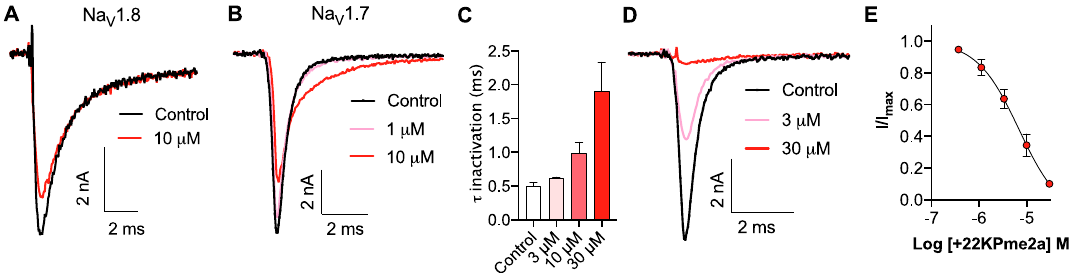
Figure 4. Activity of synthetic Pme2a and [ + 22K]Pme2a on Na V 1.8 and Na V 1.7. ( A ) Representative hNa V 1.8 current trace before (black) and after addition of Pme2a (red). Currents were elicited by a 50 ms pulse to + 10 mV from a holding potential of − 90 mV. ( B ) Representative hNa V 1.7 current trace before (black) and after addition of Pme2a (red). Currents were elicited by a 50 ms pulse to − 20 mV from a holding potential of − 90 mV. ( C ) Pme2a concentration-dependently increases the time constant of fast inactivation ( τ ) at hNa V 1.7. ( D ) Representative hNa V 1.7 current trace before (black) and after addition of [ + 22K]Pme2a (red). Currents were elicited by a 50 ms pulse to − 20 mV from a holding potential of − 90 mV. ( E ) Concentration–response curve for [ + 22K]Pme2a at hNa V 1.7 (IC 50 5.6 ± 1.1 μ M). Data are presented as the mean ± SEM, with n = 4 cells per data point.